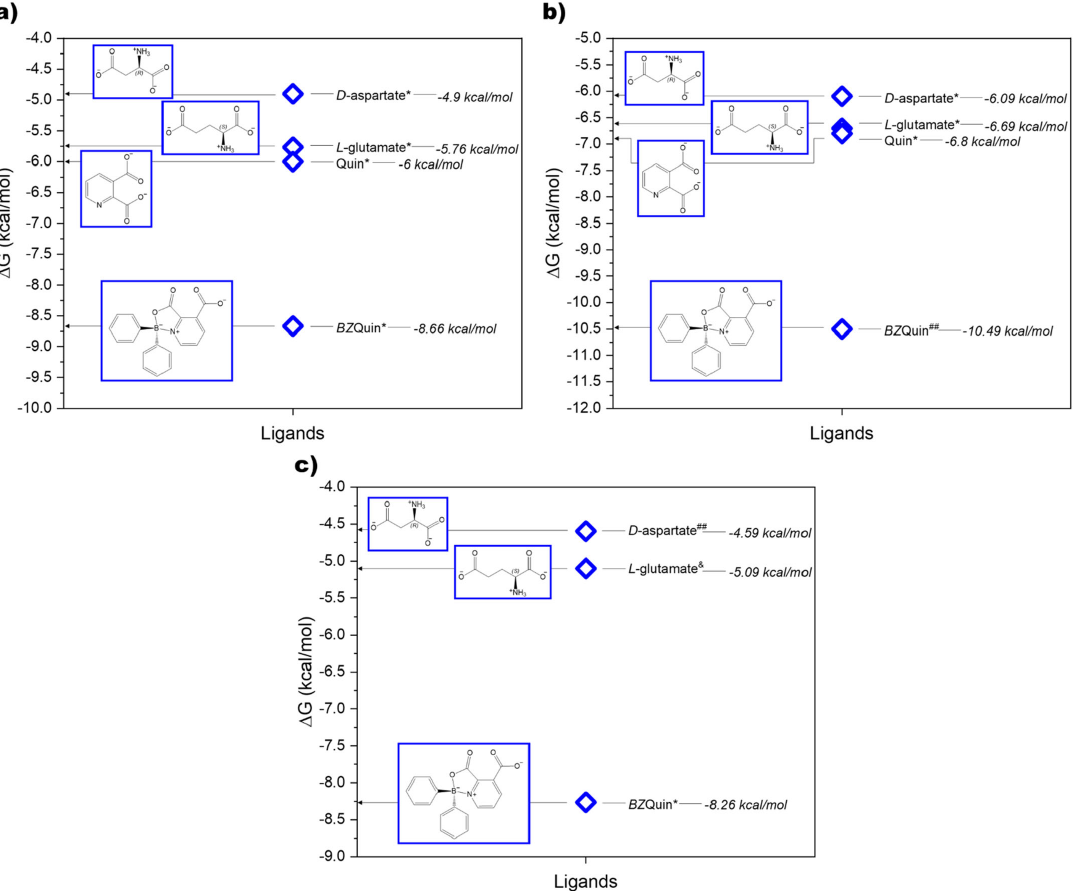
Figure 3. Ligands bound to the L ‐ glutamate sites on ( a ) mGluR1, ( b ) mGluR2, and ( c ) mGluR7. Binding affinity is quantified in Δ G , while binding probability is represented by * p > 0.8, ## p > 0.6, & p < 0.2; pH = 7.4.